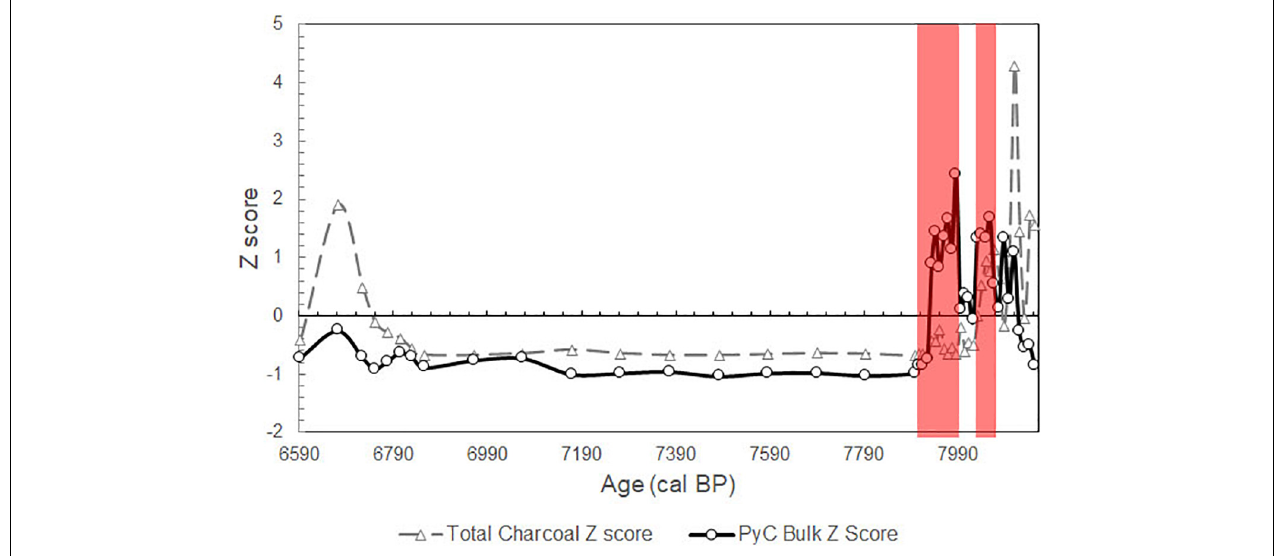
FIGURE 5 | Z scores of total charcoal particle influx (gray dashed line, triangle markers) and pyrogenic carbon influx (black line, circle markers) for Sanamere Lagoon core SAN1. High relative fire intensities (red bars) are identified by positive pyrogenic carbon Z scores and low to negative total charcoal Z